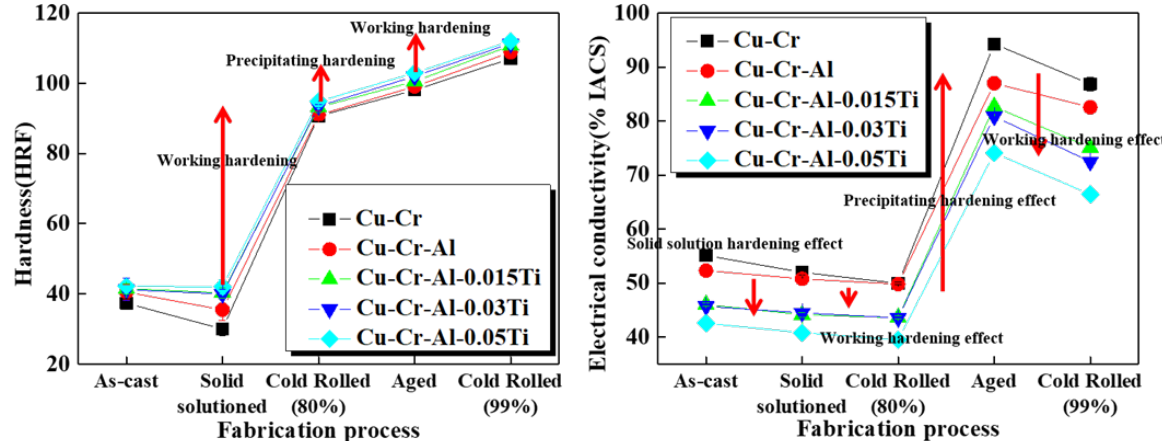
Figure 9. Variation of mechanical and electrical properties of Cu-Cr alloys.